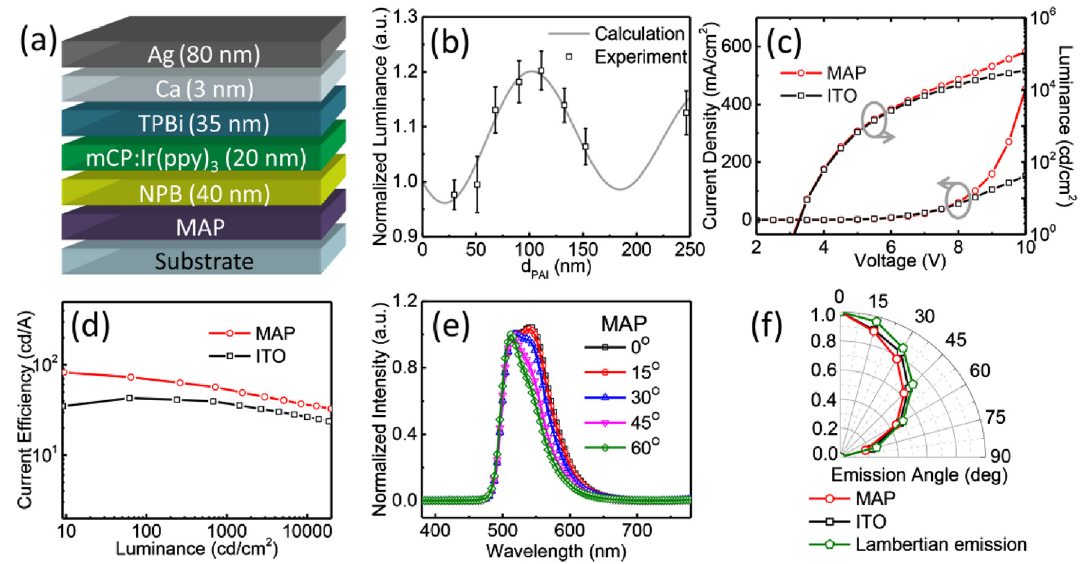
Figure 2: (a) Device structure of the Ir(ppy) 3 -based organic light-emitting devices (OLEDs). (b) Calculated and experimental values of lumi- nance normalized to its peak value as a function of polyamide-imide (PAI) thickness. Theoretical simulation results were obtained from the Setfossoftware.(c) – (d) Comparison of currentdensity – voltage – luminance(J – V – L) andcurrentef fi ciency(CE) – L characteristicsof OLEDs with MoO 3 /indium tin oxide (ITO) and metal oxide/ultrathin Ag/polymer (MAP) anodes. (e) – (f) Angular dependence of electroluminescence (EL) intensity.